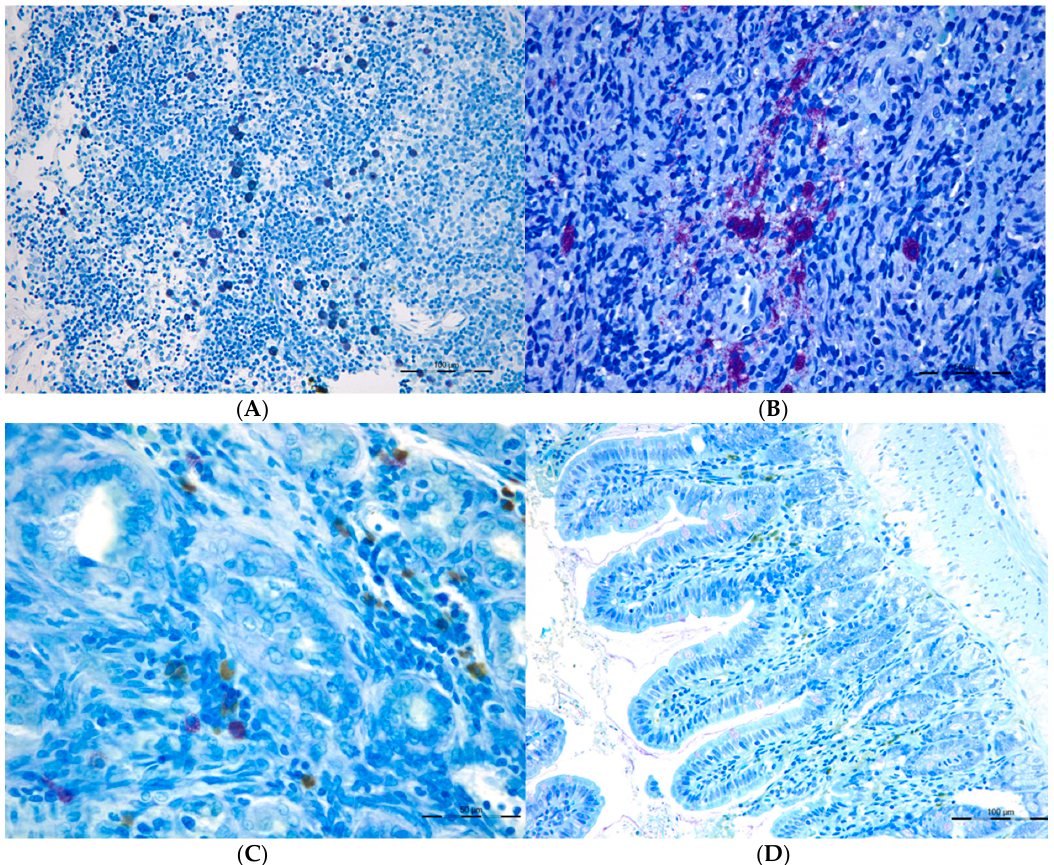
Figure 4. Connective Tissue mast cells (CTMC) were identified after stained with a 0.5% toluidine blue solution transversal sections of ( A ) the lymphatic nodes and in ( B ) spleen as granulated violet/blue cells) in cholestatic rats. Mucosal mast cells (MMC), rat mast cell protease 2 (RMCP-II), green immunopositive cells in ( C ) the liver and ( D ) in the ileum of microsurgical cholestatic rats. Immunodetection of RMCP-II, specific marker of mucosal mast cells (MMC) in the rats, was carried out using a specific rat monoclonal antibody (1:500; Moredun Animal Health, Edinburgh, UK). The size of the calibration bars throughout all images was 100 µm.